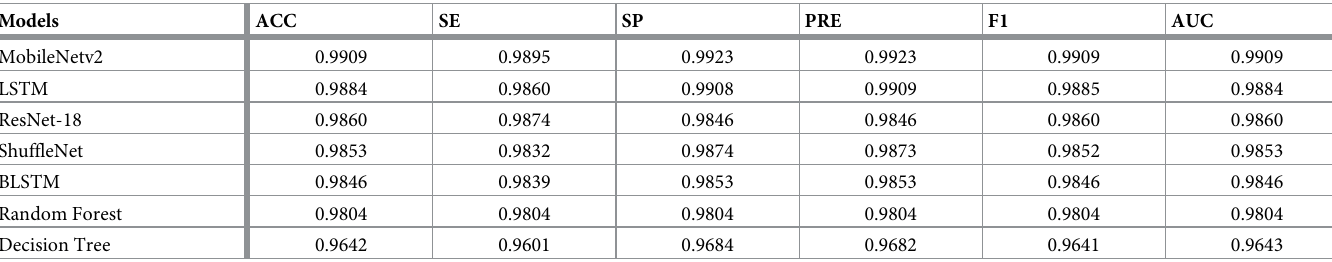
Table 12. Final results (2 nd